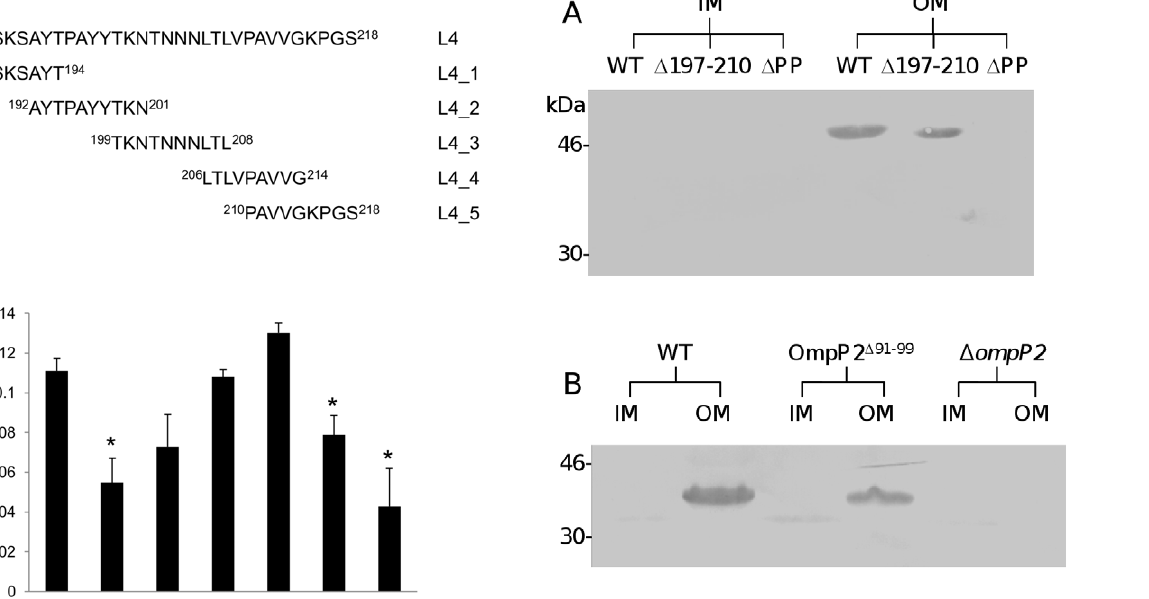
Figure 5. Immunoblots confirm the presence of truncated porins in outer membrane-enriched sub-cellular fractions. Inner and outer membrane fractions (labeled IM and OM, respectively) of MC58 wild-type, MC58PorA D 197–210 D pilQ (labeled D 197–210) and MC58 D porA D pilQ double mutant (labeled D PP) (A) or H. influenzae Rd KW20 wild-type, OmpP2 D 91–99 and D ompP2 (B) were probed with anti- PorA monoclonal antibody or rabbit polyclonal anti-OmpP2, respec- tively.